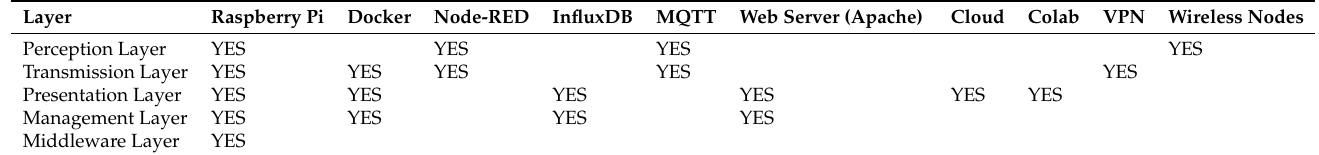
Table 3. The HW and SW mapping towards layers.